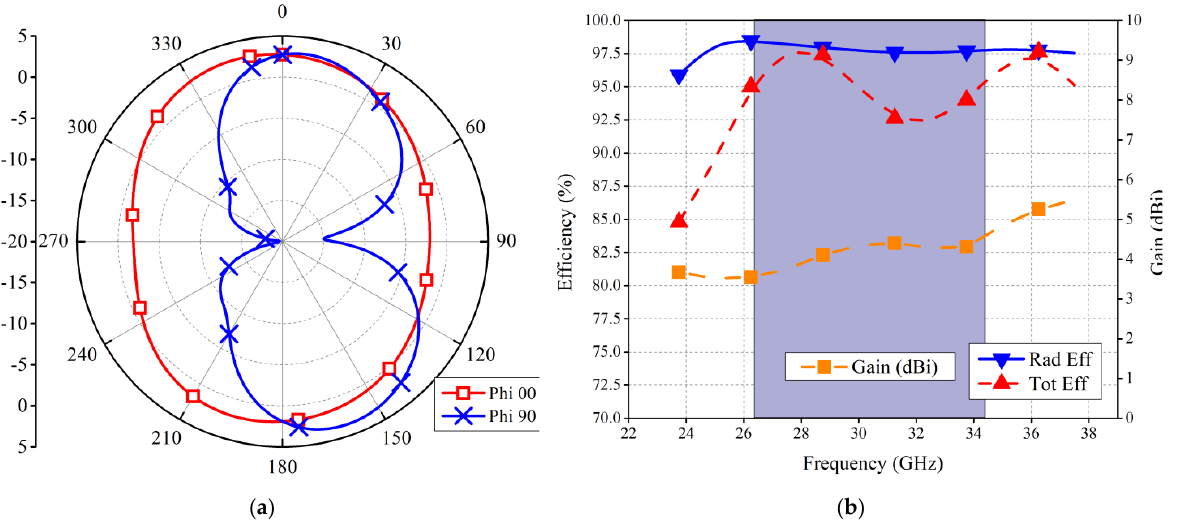
Figure 4. Single-Element Performance Parameters ( a ) Radiation Patterns ( b ) Gain and Efficiency.